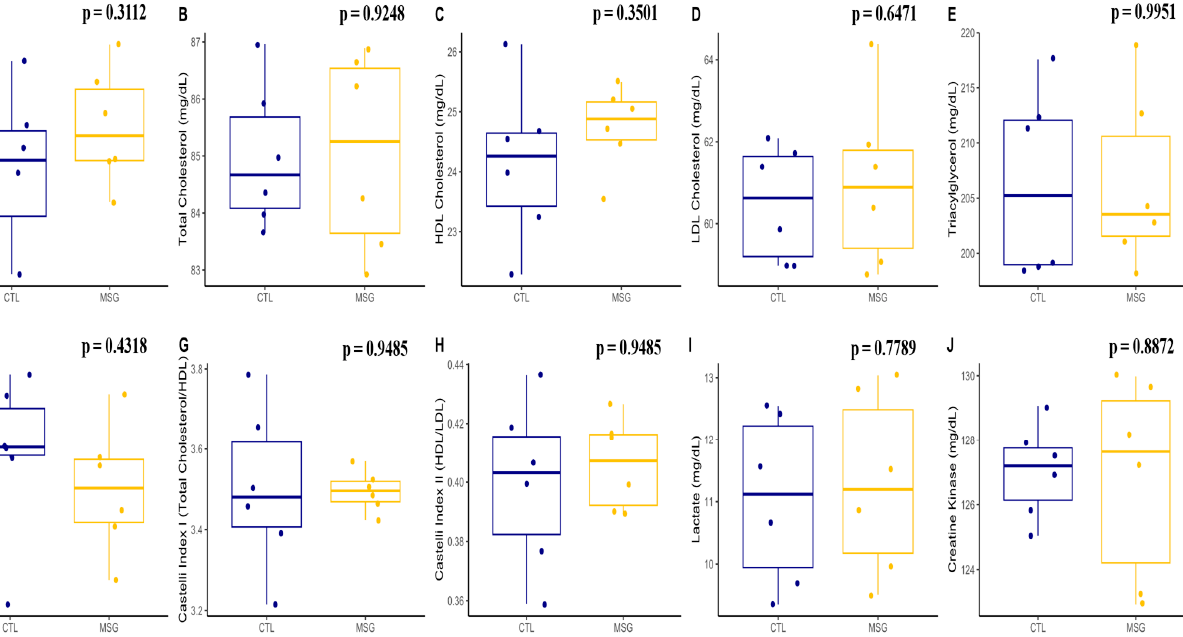
Figure 4. Graphs related to corporal characterization in PND15: ( A ): body weight (g); ( B ): nasoanal length (cm); ( C ): Lee index (g/cm 3 ). The CTL is represented in blue and the MSG group is repre- sented in yellow. The letter a represents the difference between the MSG group when compared to the CTL. All data: Student’s t -test.